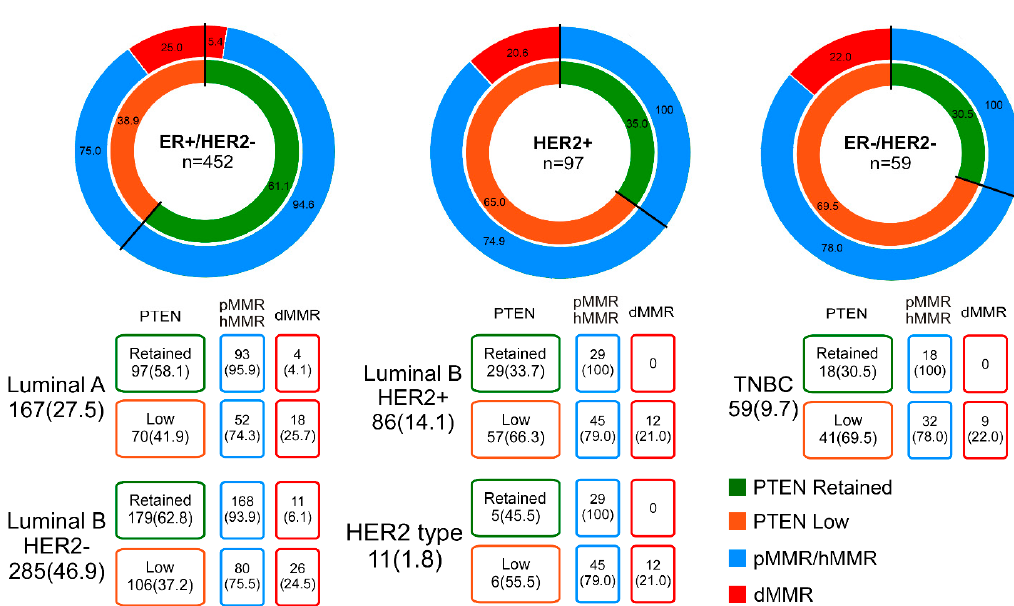
Figure 2. PTEN and mismatch repair protein expression across different biomarker-based subgroups of breast cancer patients. ER, estrogen receptor; TNBC, triple-negative breast cancer; pMMR, mismatch repair proficient; hMMR, mismatch repair heterogeneous; dMMR, mismatch repair deficient. In the ER +/ HER2- cluster ( n = 452), which encompasses both Luminal A ( n = 167) and Luminal B HER2- ( n = 285) breast cancers, a significant association of the MMR status according to PTEN IHC was observed ( p < 0.0001, Fisher’s exact test) (Tables 1 and